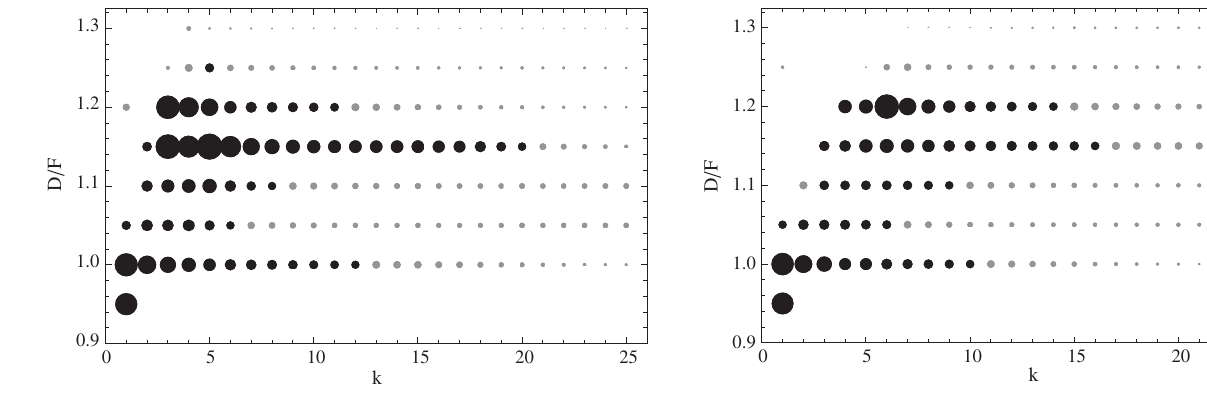
FIG. 50. The acceptances for 30 m of transport line using cells with nonscaling magnets in a DFFD configuration. The size of the dots are proportional to the square root of the acceptance. Black dots represent acceptances > 10 mm mrad and grey dots represent lower acceptances. For scale: the largest acceptance (at